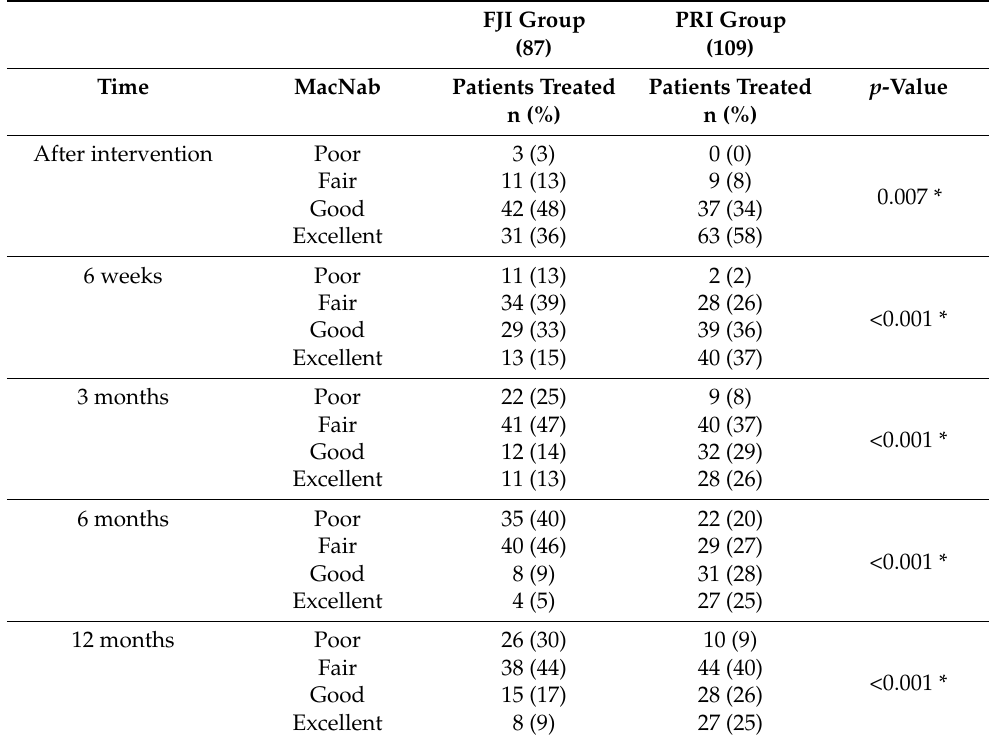
Table 5. Patients’ satisfaction with infiltration therapy according to